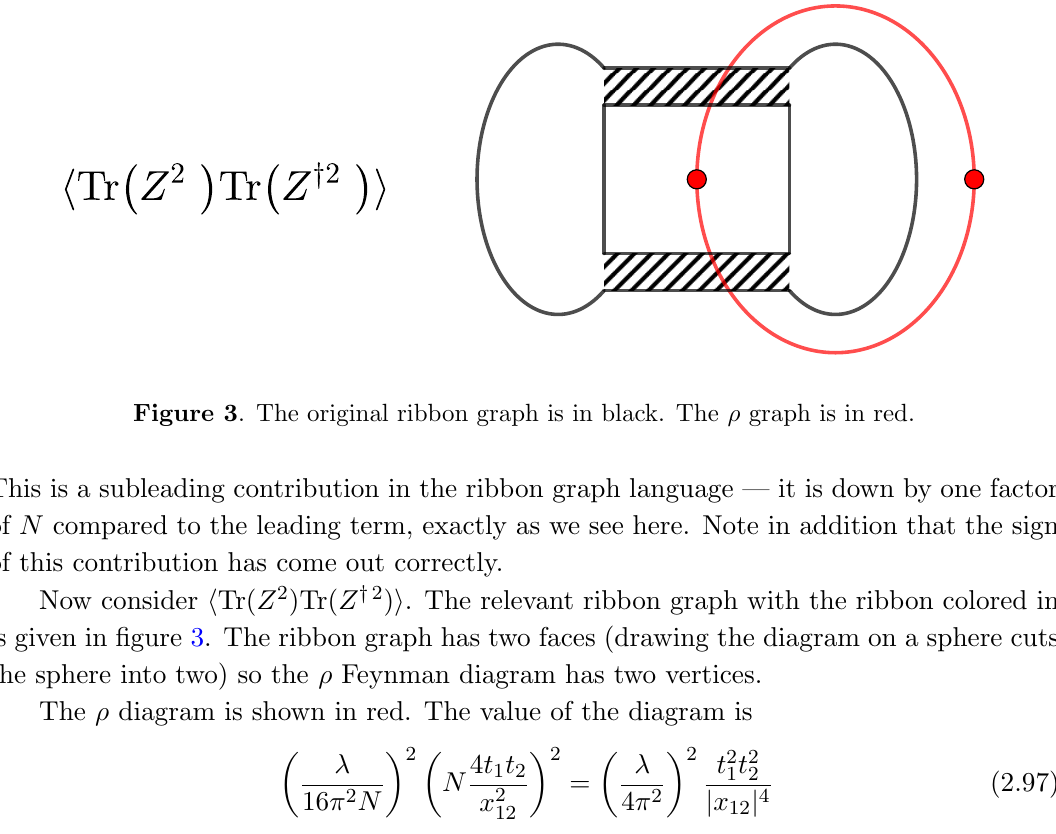
Figure 2 . The original ribbon graph is in black. The (cid:26) graph is in red.